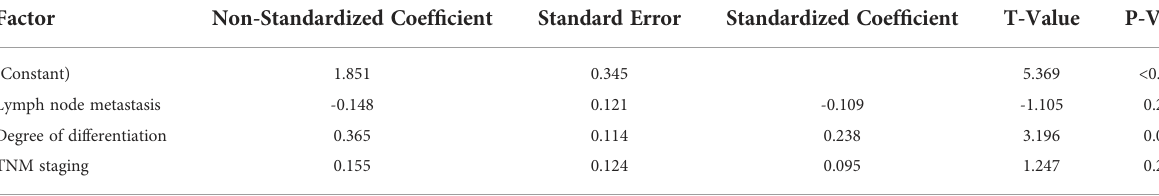
TABLE 3 Multi-factor analysis of the in fl uencing factors of the TNF- a level in patients with colorectal cancer.